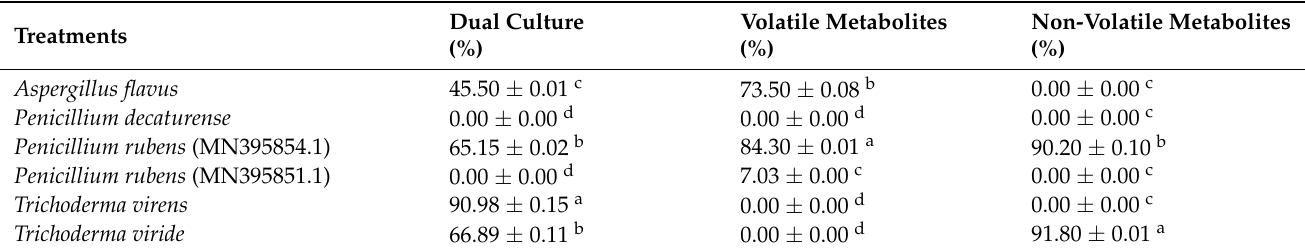
Table 2. Effect of antagonistic fungi on the mycelium growth inhibition of Sclerotium rolfsii in the dual culture, volatile metabolites, and non-volatile metabolites methods.